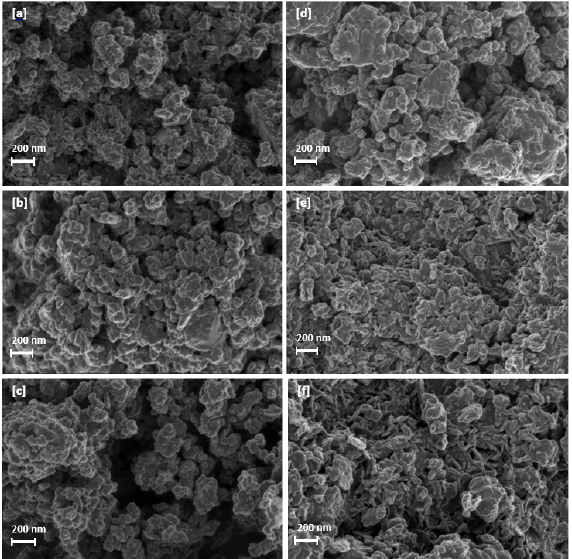
Figure 20. ( a ) Mg-Al LDH sample synthesised at a jacket water inlet temperature of 30 °C for 1 h (S4). ( b ) Mg-Al LDH sample synthesised at a jacket water inlet temperature of 30 °C for 2 h (S5). ( c ) Mg-Al LDH sample synthesised at a jacket water inlet temperature of 30 °C for 3 h (S6). ( d ) Mg-Al LDH sample synthesised at a jacket water inlet temperature of 50 °C for 1 h (S10). ( e ) Mg-Al LDH sample synthesised at a jacket water inlet temperature of 50 °C for 2 h (S11). ( f ) Mg-Al LDH sample synthesised at a jacket water inlet temperature of 50 °C for 3 h